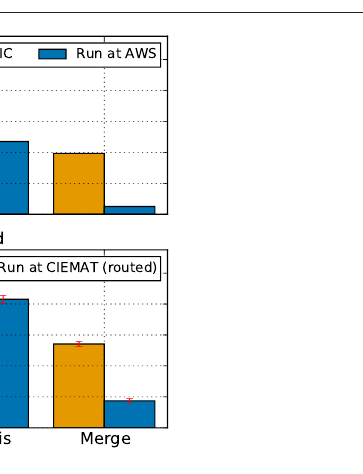
Figure 4: CPU e ffi ciency by job type, for normal PIC jobs (left / orange bars) and PIC jobs run elsewhere (right / blue bars): AWS (top plot) or CIEMAT (bottom plot).